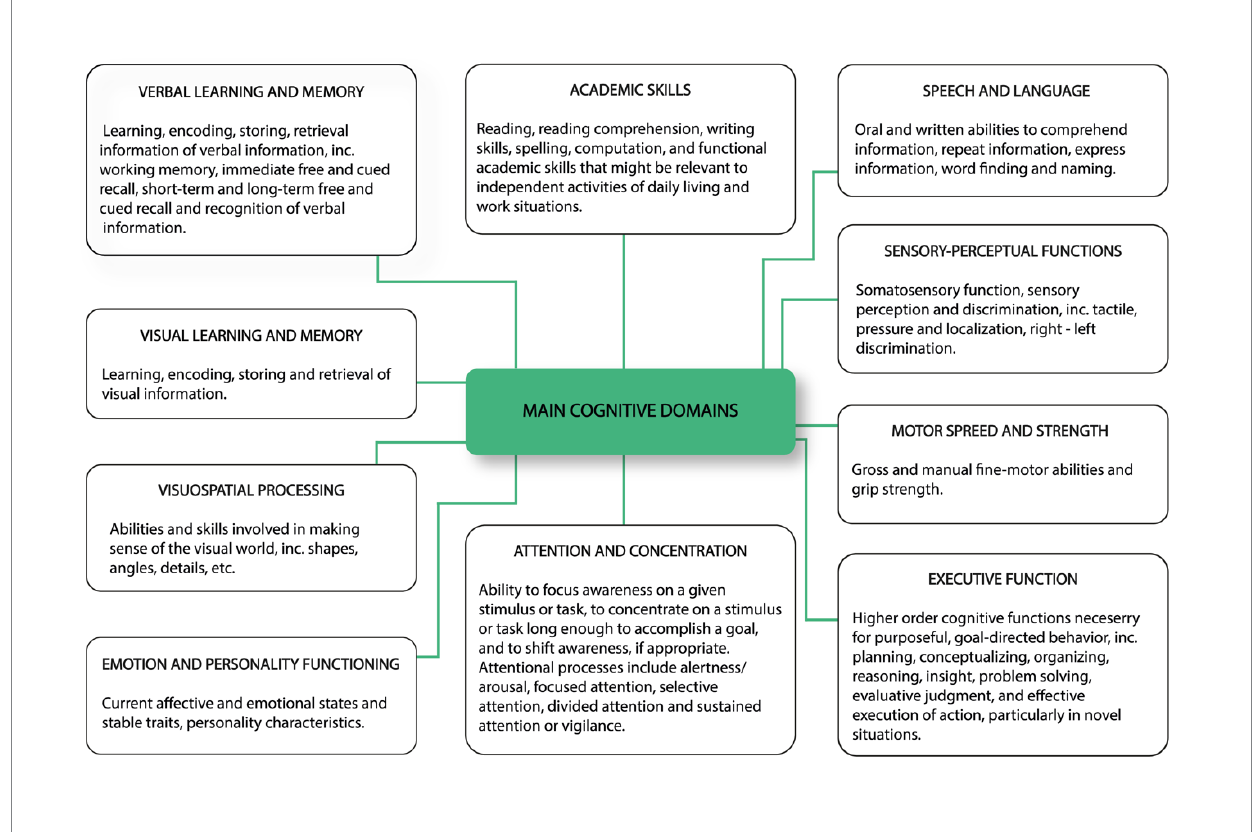
FIGURE 3 Characteristics of basic cognitive functions for neuropsychological evaluation of cancer patients. The proposed domains include learning and memory, visual learning and memory, visuospatial processing, emotion and personality functioning, academic skills, speech and language, sensory and language, sensory-perceptual functions, motor speed and strength, executive functions as well as attention and concentration (Pendergrass et al., 2018,